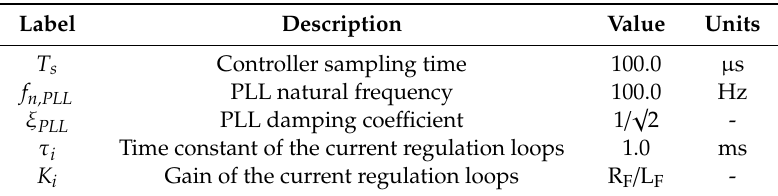
Table 2. Summary of VOC